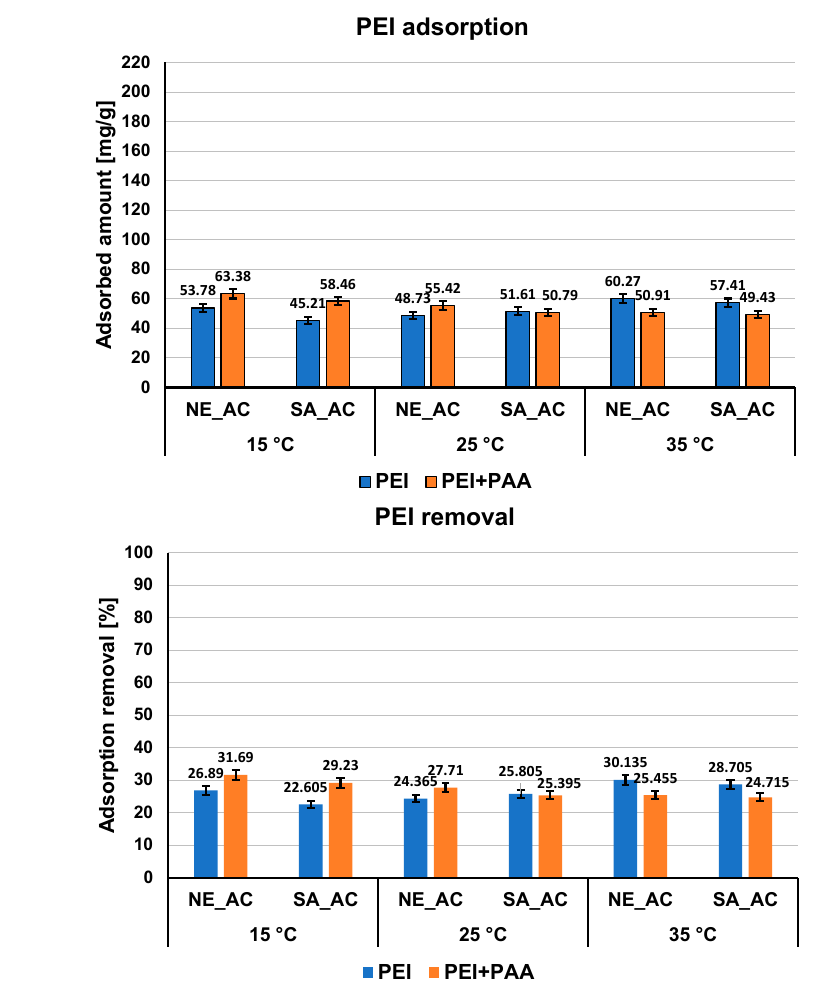
Figure 3. PEI adsorbed amounts ( a ) and its percentage removal ( b ) from the activated carbons surface in single and mixed systems of adsorbates at three examined temperatures, pH 3.